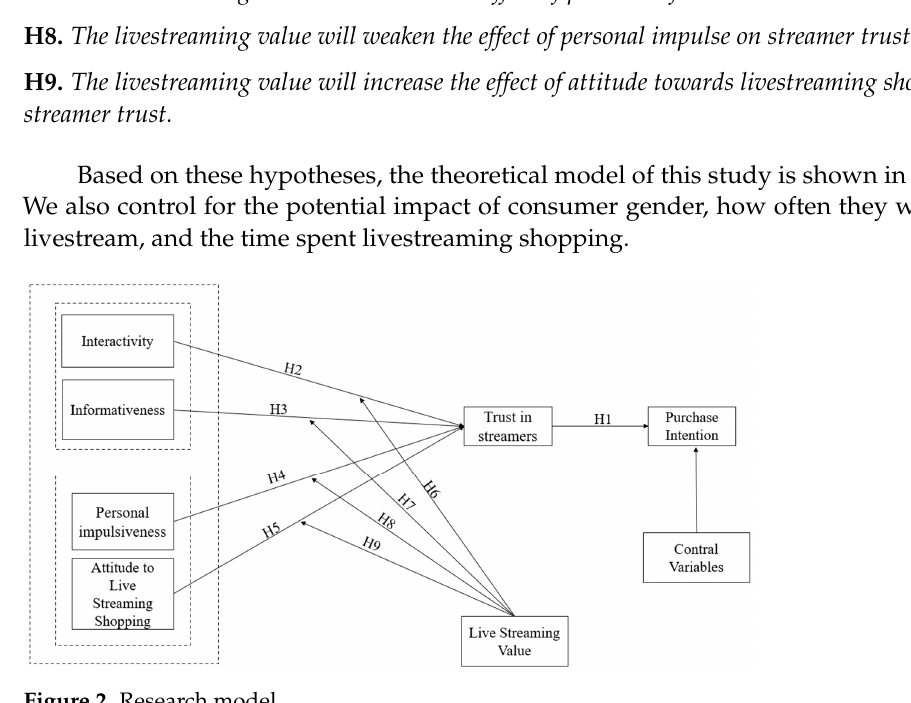
Figure 2. Research